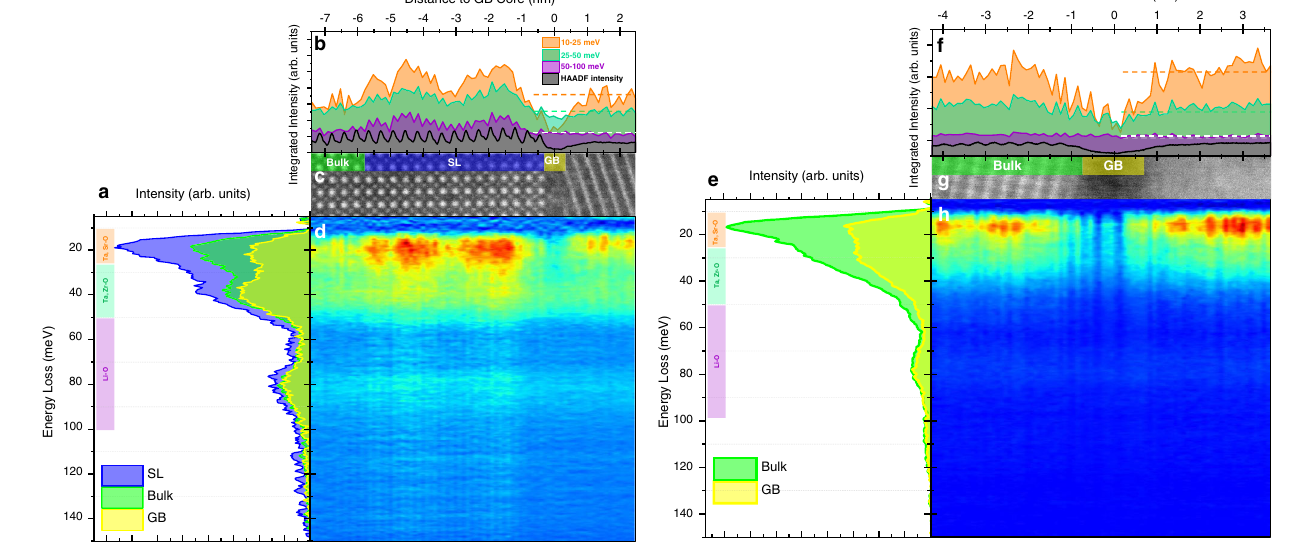
stackedhorizontally.Theverticalaxisdenotesenergylosswhilethehorizontalaxis denotes the horizontal real-space position labeled in the horizontal axis of ( b ). e Representative vibrational spectra at the bulk and GB regions of a general GB. f Line pro fi les of the averaged intensities denoted in ( e ) overlaid with a vertically integratedHAADFlinepro fi le.TheintensityoftheTa-,Sr-Ovibrationsshowalarge dip at the GB, the B-site vibrational intensity (Ta-, Zr-O) shows a smaller dip, while thevibrationalEELSsignalcorrespondingtoLi-Ovibrationsshowsnochangefrom bulkatthe GB.Plot labelsare the same asin( b ). g HAADF image corresponding to the region the general GB spectra were acquired. h Contour plot of vertically- integrated spectral slices stacked horizontally. The streaks in d , h indicate atomic resolution vibrational mapping 52